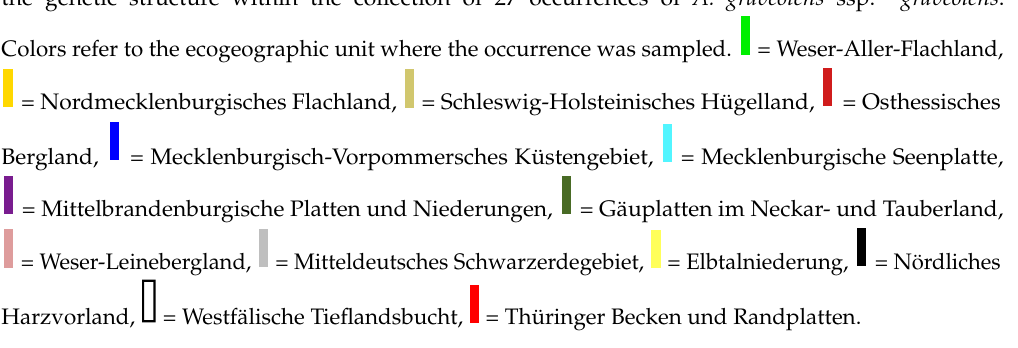
= Weser-Leinebergland, = Mitteldeutsches Schwarzerdegebiet, = Westfälische Tieflandsbucht, = Thüringer Becken und Randplatten. = Thüringer Becken und